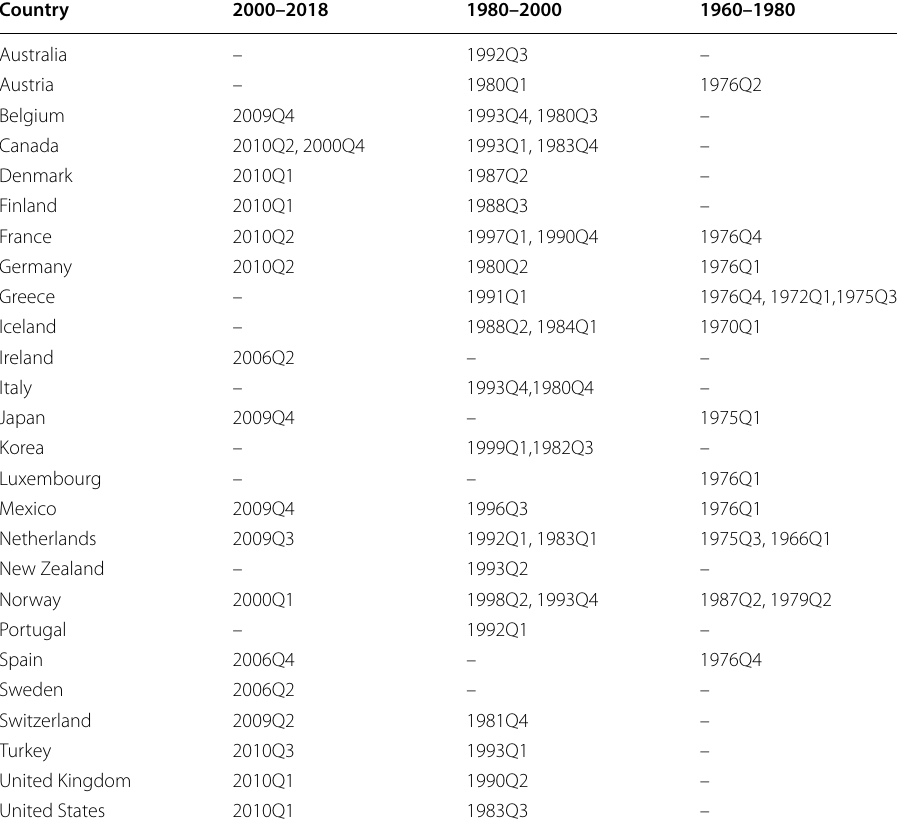
Table 2 Country-level Inclan–Tiao test